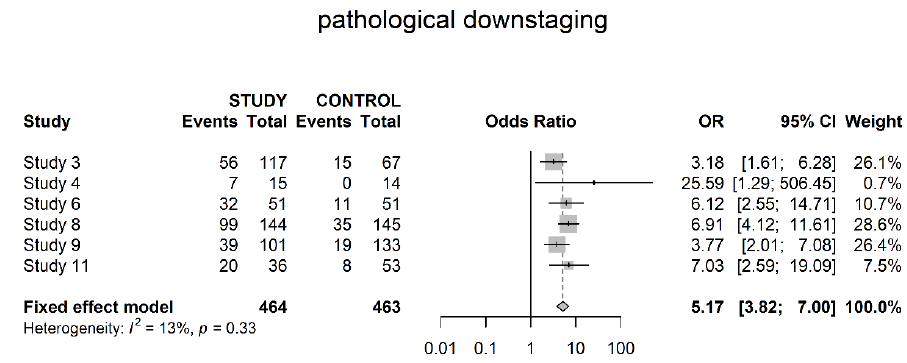
Figure 10. Lymphovascular invasion. 3.4. Oncological Outcomes Two studies presented three-year OS, showing a significant benefit for the study groups (OR 3.80; 95% CI 1.80; 8.01) (Figure 11) . Figure 11. Three-year overall survival. Six studies reported on five-year OS, also showing a significant difference in favor of the study groups (OR 2.46; 95% CI 1.45; 4.16) (Figure 12) .